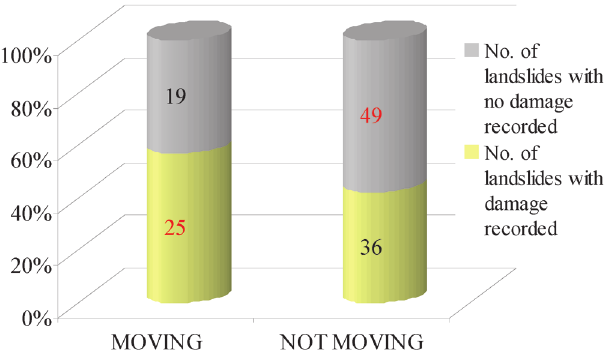
Fig. 20. Comparison among PS-derived evidence of movement on landslides and the results of damage